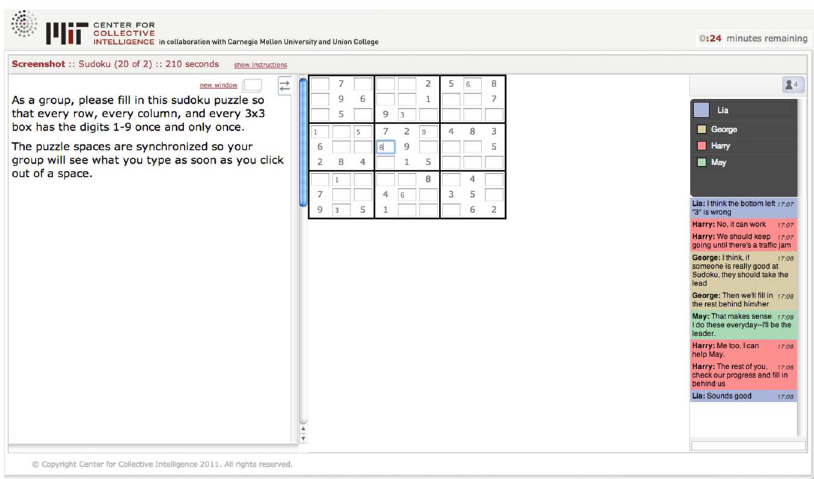
Fig. 1. A screenshot of a group solving a Sudoku task. The right-hand chat window allows the group to communicate. The middle task panel is where the group enters its answers. The left-hand instructions panel contains instructions and other stimulus materials for the